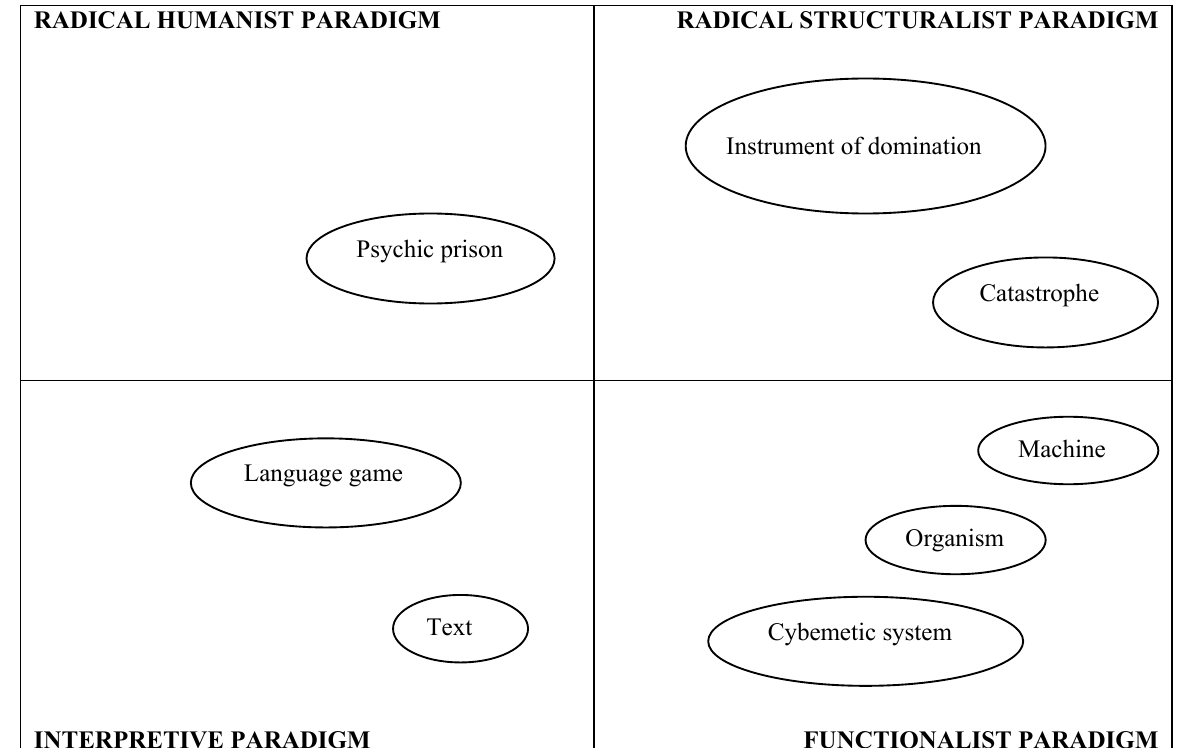
Figure 1: Paradigms and selected metaphors of organisations Source: Adapted from Morgan